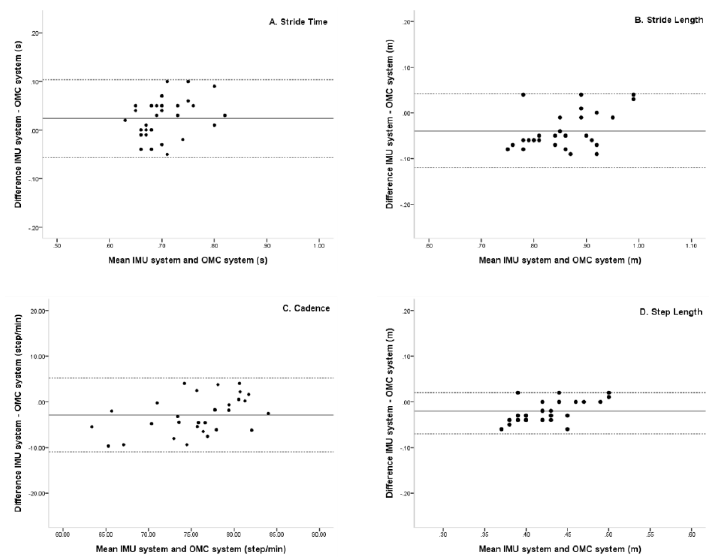
Figure 3. Bland–Altman plots comparing IMU system (LEGSys + ) and OMC system (Qualisys) results for ( A ) Stride time, ( B ) Stride length, ( C ) Cadence, and ( D ) Step length left and right. Bias (solid line) and limits of agreement are (dashed line) shown for each variable. The mean score is plotted on the x-axis, and the difference between the two devices is plotted on the y-axis (mean difference ± 1.96 SD).